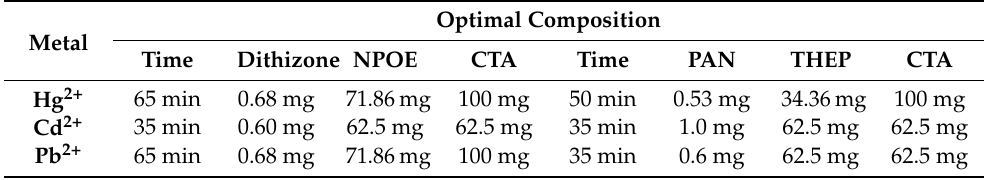
Table 7. Optimal parameters obtained after applying the M3 processing